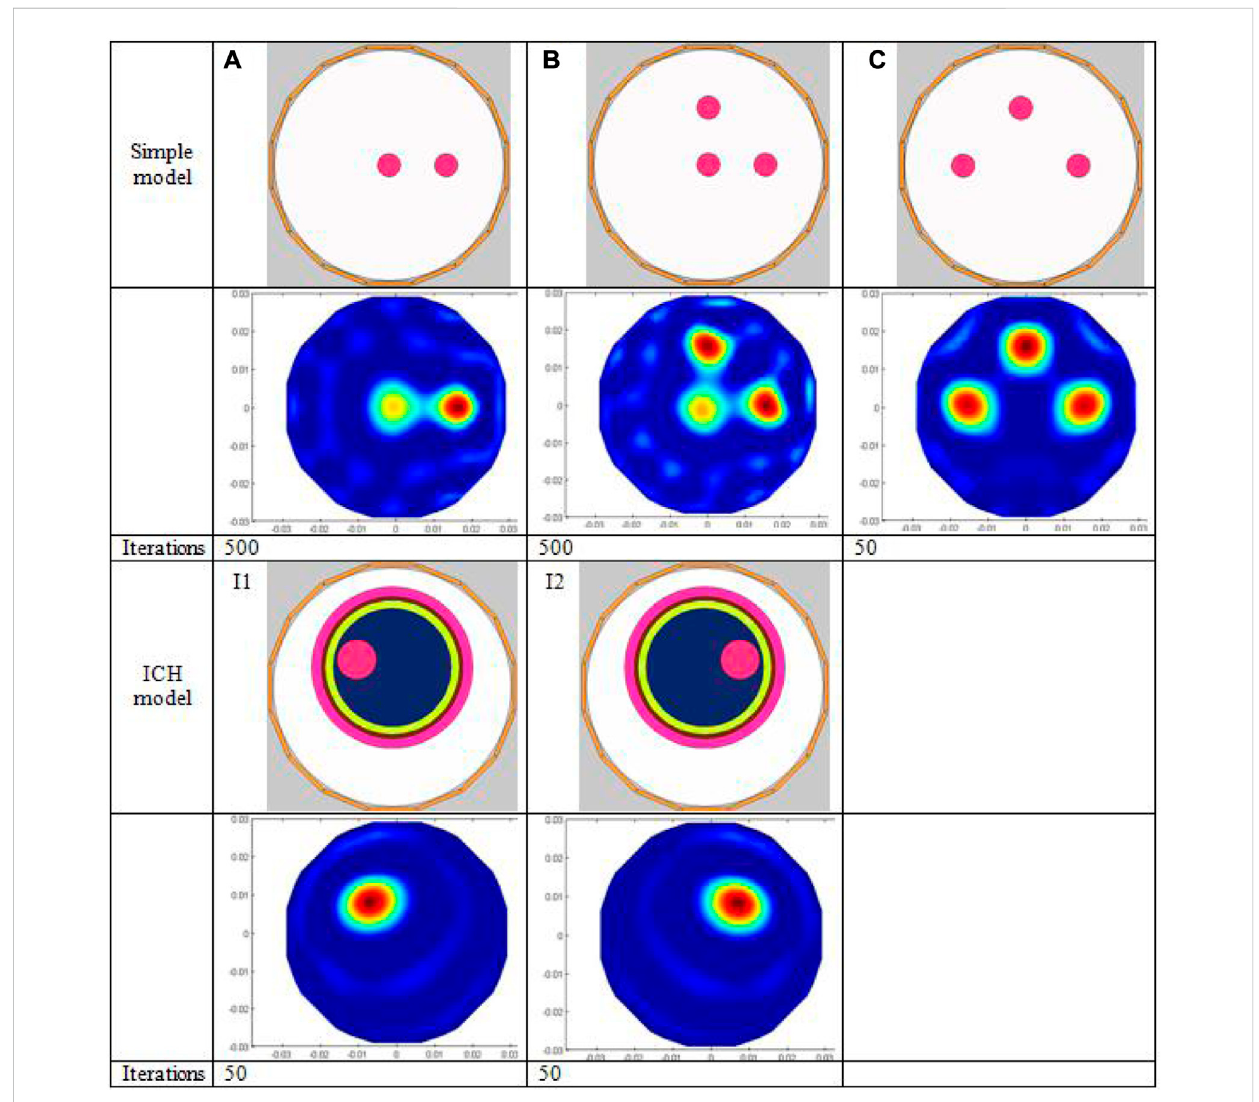
FIGURE 3 Simulation modelandimagingresults. The fi rstthreerowsshow thesimple simulationmodels (A – C) followedbythecorrespondingimagingresults and the number of iterations; the last three rows show the two ICH models (I1, I2), the corresponding imaging results, and the number of iterations, respectively